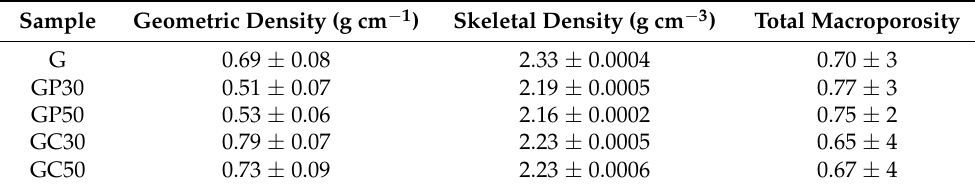
Table 3. The density and porosity of foamed geopolymer and composite materials. Geometric density was measured with the geometric method; skeletal density was measured by the helium pycnometer; total porosity was evaluated based on geometric and skeletal density. Sample